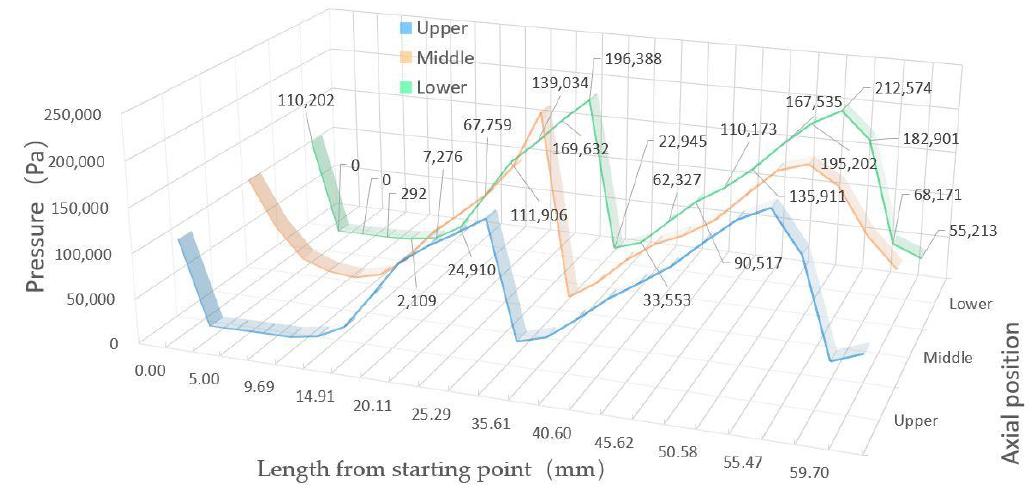
Figure 21. Pressure distribution of axial measuring points inside the impeller.